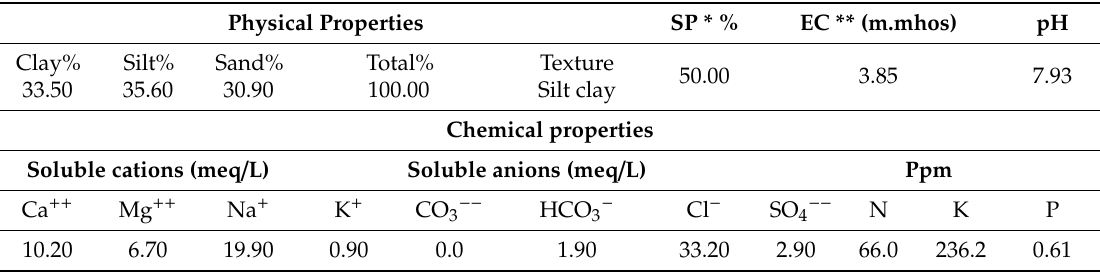
Table 1. Physical and chemical characteristics of the soil used in this